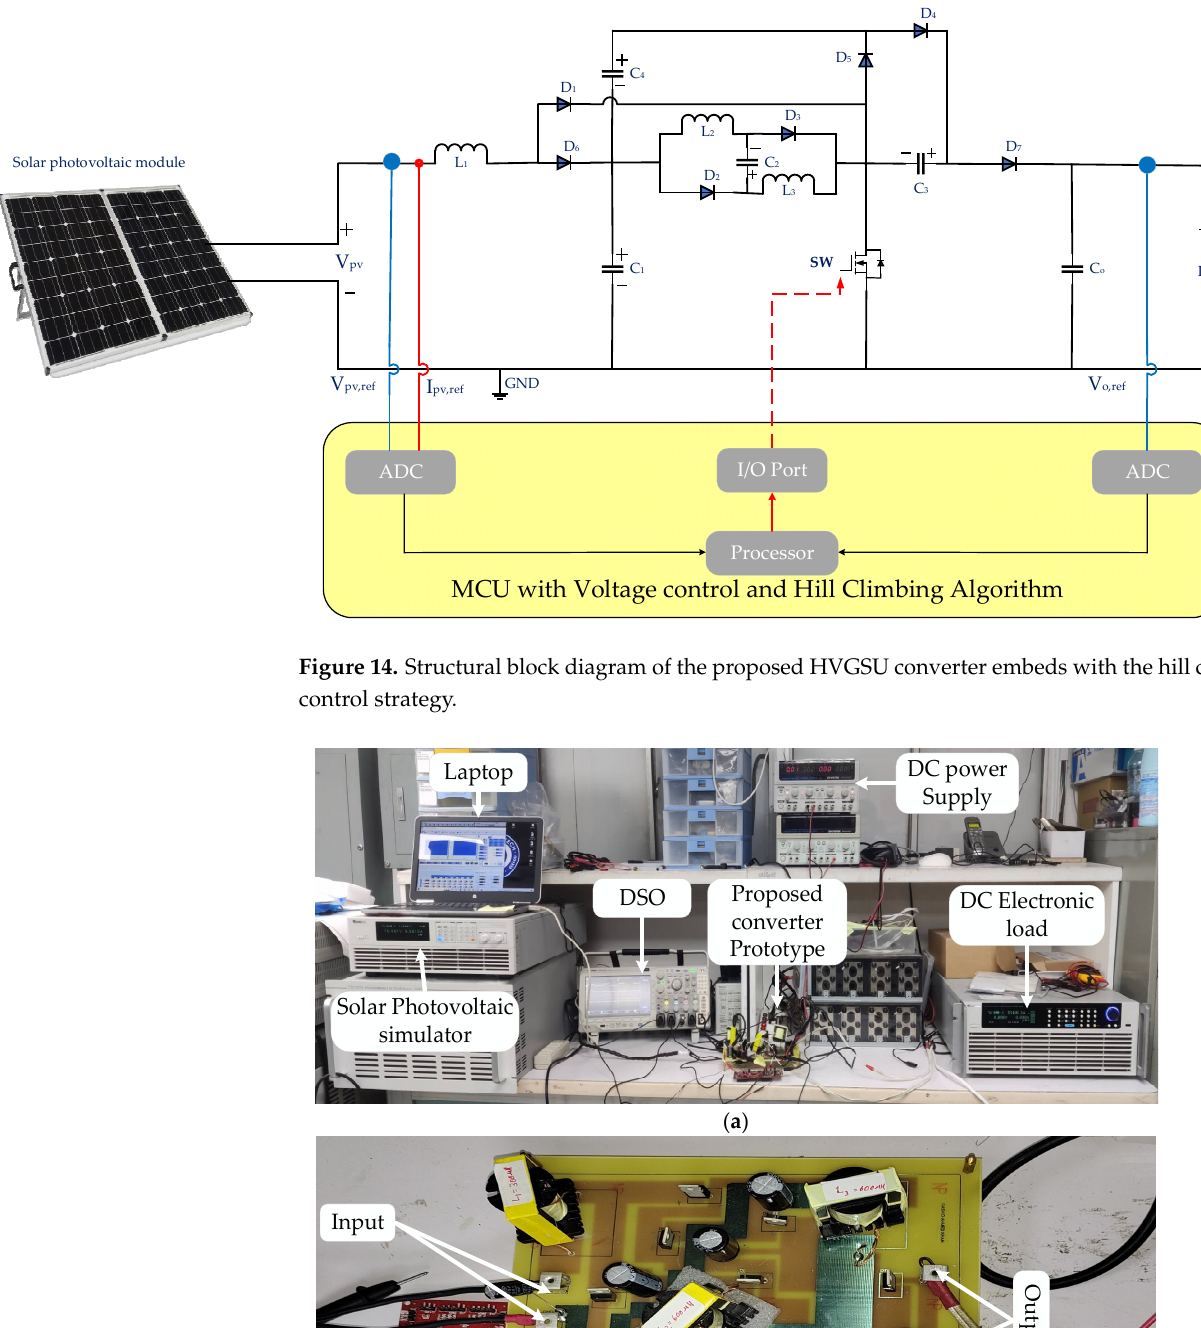
V PV V O Figure 16. Experimental waveform for gate source voltage (V GS ), solar photovoltaic simulator output voltage (V PV ), and output voltage (V o ) for the proposed HVGSU converter at the 0.54 duty cycle (Hor: 20 µs/div). Figure 17 depicts the measured waveforms for the solar PV simulator (V pv ) and output voltage (V o ) for the proposed HVGSU converter, with an input voltage of 25 V and a duty cycle of 0.48, in order to generate a DC microgrid voltage of 380 V (as shown in Figure 1). In